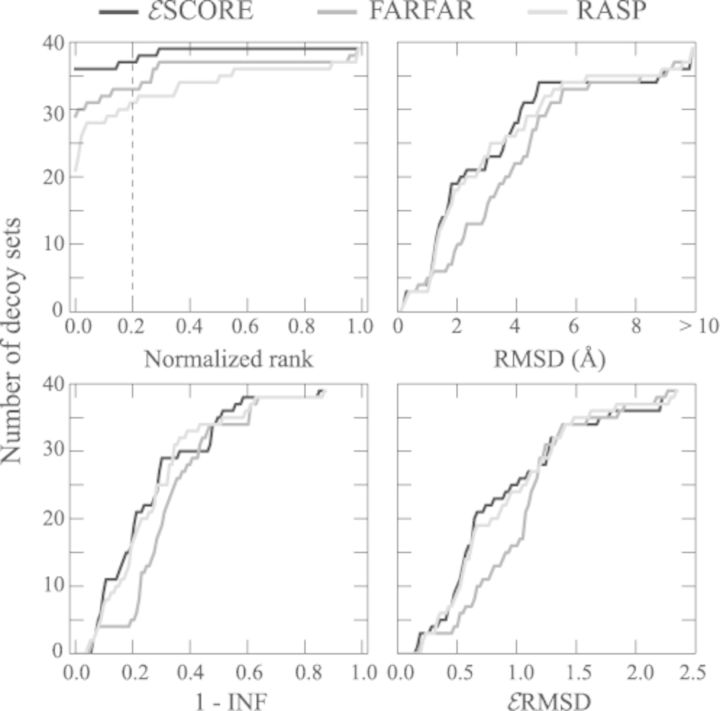
Quantitative comparison of our scoring function \documentclass[12pt]{minimal}
\usepackage{amsmath}
\usepackage{wasysym}
\usepackage{amsfonts}
\usepackage{amssymb}
\usepackage{amsbsy}
\usepackage{upgreek}
\usepackage{mathrsfs}
\setlength{\oddsidemargin}{-69pt}
\begin{document}
}{}$\mathcal {E}$\end{document}SCORE with FARFAR (15) and RASP (17) on 39 different decoy sets. In the upper left panel, number of decoy sets with normalized rank lower than the value on the horizontal axis. For example, the normalized rank is 0.2 or less for 37 out of 39 decoy sets using the \documentclass[12pt]{minimal}
\usepackage{amsmath}
\usepackage{wasysym}
\usepackage{amsfonts}
\usepackage{amssymb}
\usepackage{amsbsy}
\usepackage{upgreek}
\usepackage{mathrsfs}
\setlength{\oddsidemargin}{-69pt}
\begin{document}
}{}$\mathcal {E}$\end{document}SCORE, 33/39 using FARFAR and 31/39 using RASP. The faster the curve reaches 39, the better the performance of the scoring function. In the other panels, equivalent plots for RMSD, INF (27) and \documentclass[12pt]{minimal}
\usepackage{amsmath}
\usepackage{wasysym}
\usepackage{amsfonts}
\usepackage{amssymb}
\usepackage{amsbsy}
\usepackage{upgreek}
\usepackage{mathrsfs}
\setlength{\oddsidemargin}{-69pt}
\begin{document}
}{}$\mathcal {E}$\end{document}RMSD of the best scoring decoy to the native structure, as labeled. See Supplementry Table S6 for a complete list of results.